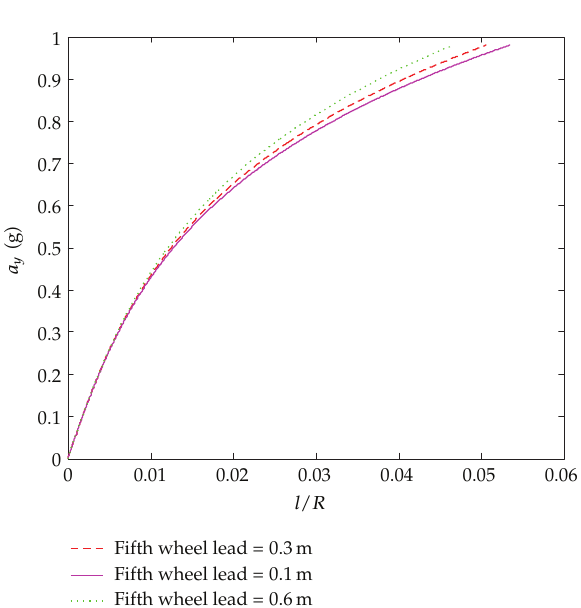
Figure 11: Handling diagram for a tractor semitrailer with one rear axle and varying fifth wheel leads. (cid:6) 1 (cid:7) Tractor semitrailers with two rear axles have better handling stability than